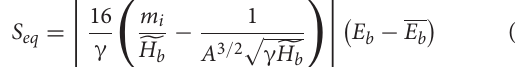
shows the wave scenario functions determined using the peak wave height in deep water H o for the real-time scale t real and the p corresponding wave energy at the breaking